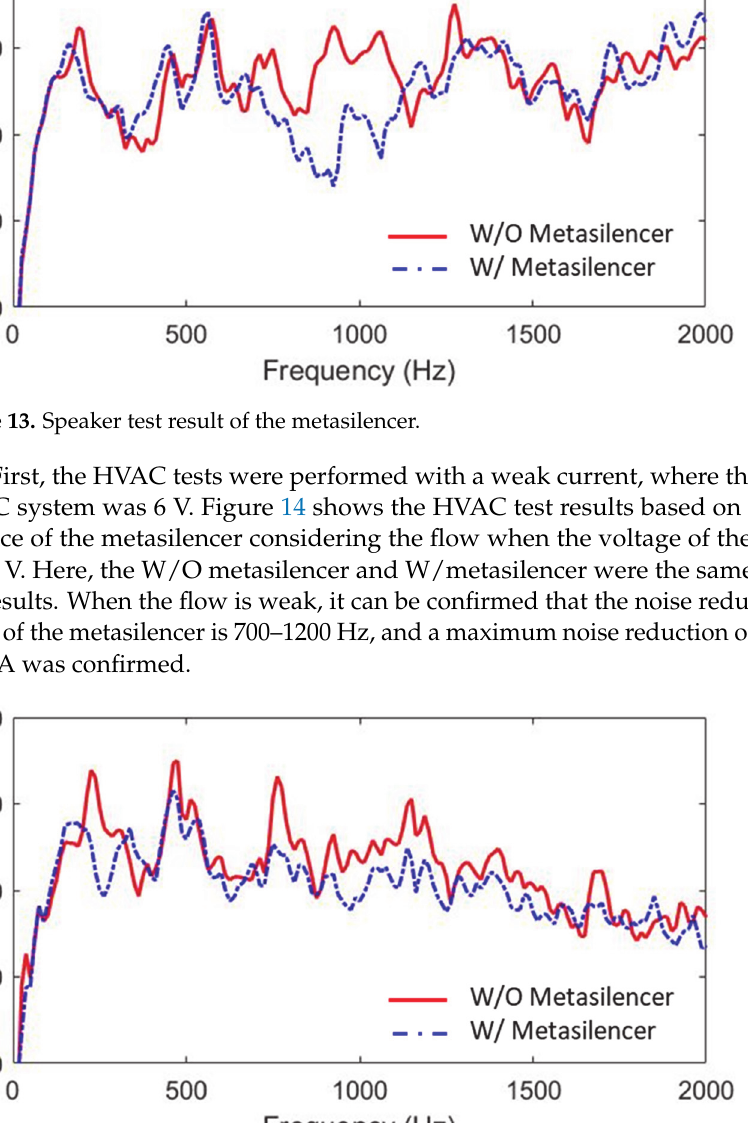
Figure 12. Scattered field at metasurface: ( a ) 900 Hz; ( b ) 1000 Hz.